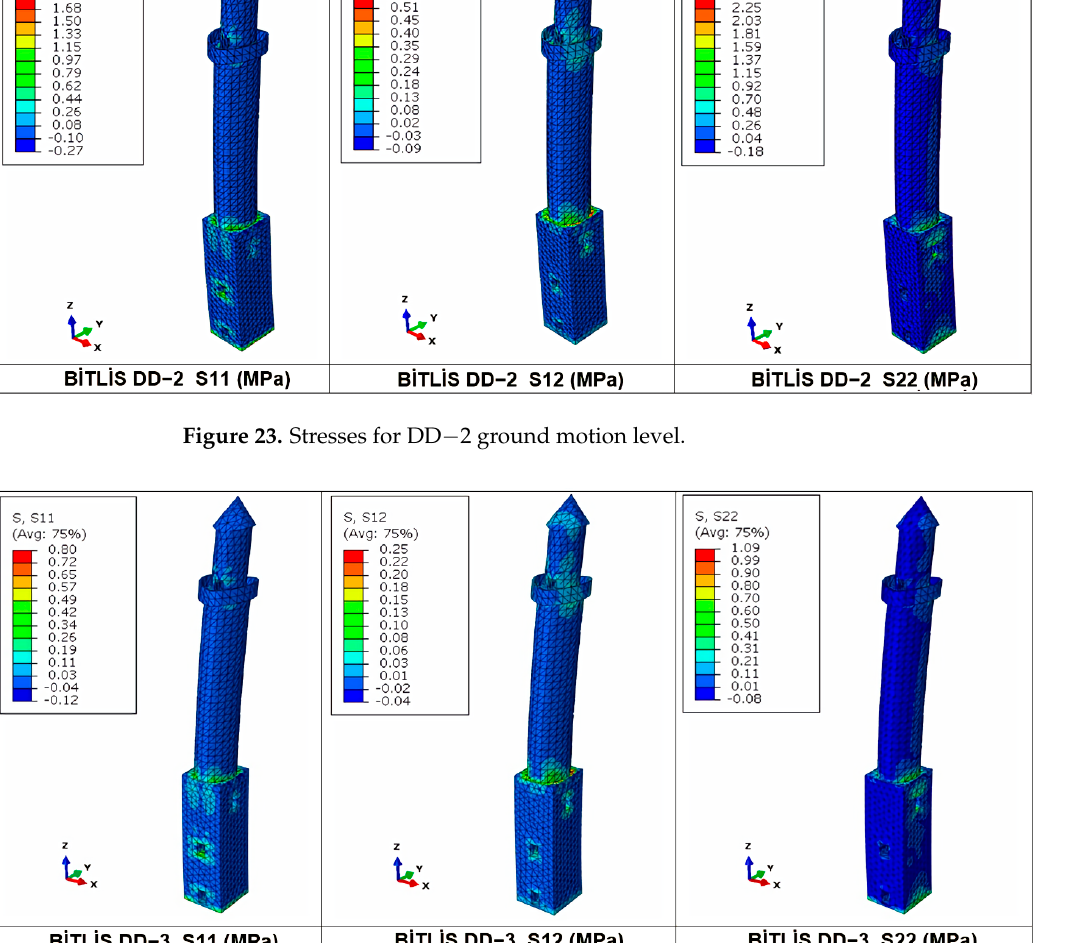
Figure 24. Stresses for the DD − 3 ground motion level.